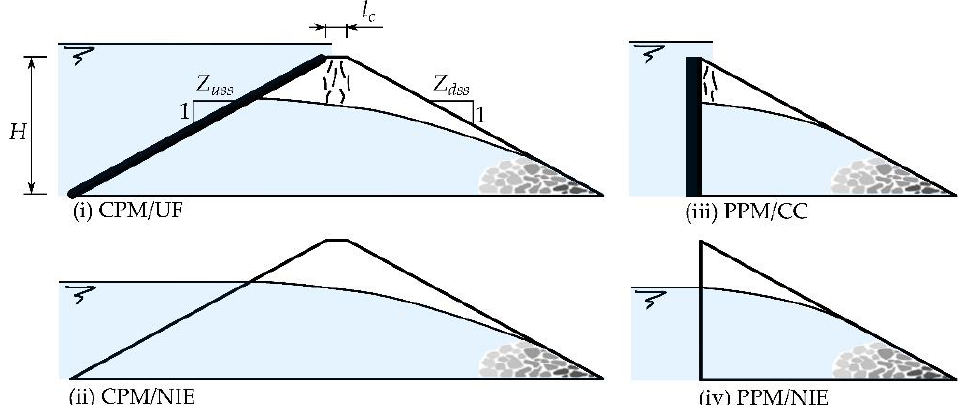
Figure 1. Schematic drawing of the different types of physical models tested at the laboratory: ( i ) Complete Physical Models with Upstream Face, ( ii ) Complete Physical Models with No Impervi- ous Element, ( iii ) Partial Physical Models with Central Core and ( iv ) Partial Physical Models with No Impervious Element.